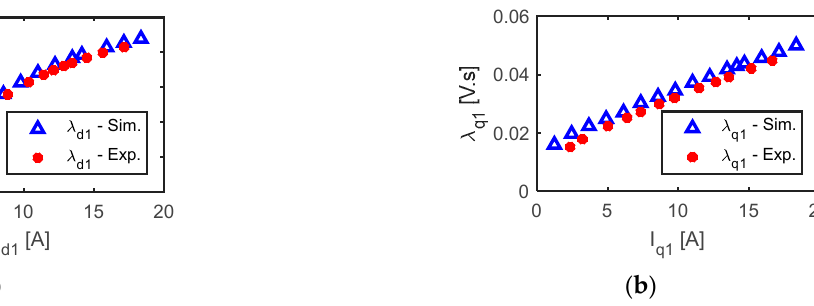
( d ) ( e ) Figure 16. Dynamic performance of drive system at current angle of 50° and current changes from 8.65 A to 4.325 A; ( a ) fundamental d-axis current, ( b ) fundamental q-axis current, ( c ) third-harmon- ics dq-axis currents, ( d ) five-phase currents, and ( e ) the time response of the output torque. The dynamic performance of the drive system under torque control, at 8.65 A and with current angle changes from 50° to 20°, is reported in Figure 17. Figure 17a,b show the fundamental d-axis and q-axis currents respectively. Figure 17c shows that the output torque decreased from 5.7 N m to 3.3 N m when the current angle changed from 50° to 20°. The feedback values of the output torque and dq-axis currents follow their reference values. Furthermore, a reasonable agreement between simulation and experimental ob- servations was observed.